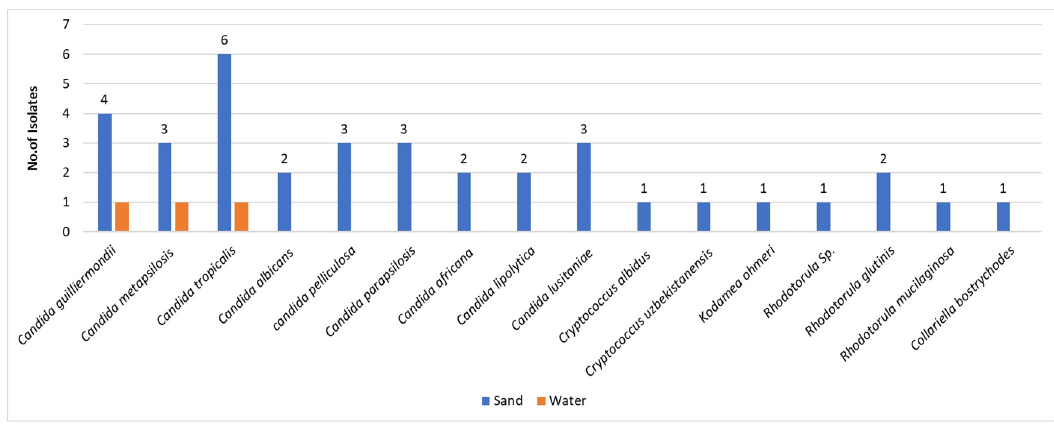
Figure 2. Number of isolates/yeast species in sand and water. The Y-axis represents the number of isolates.